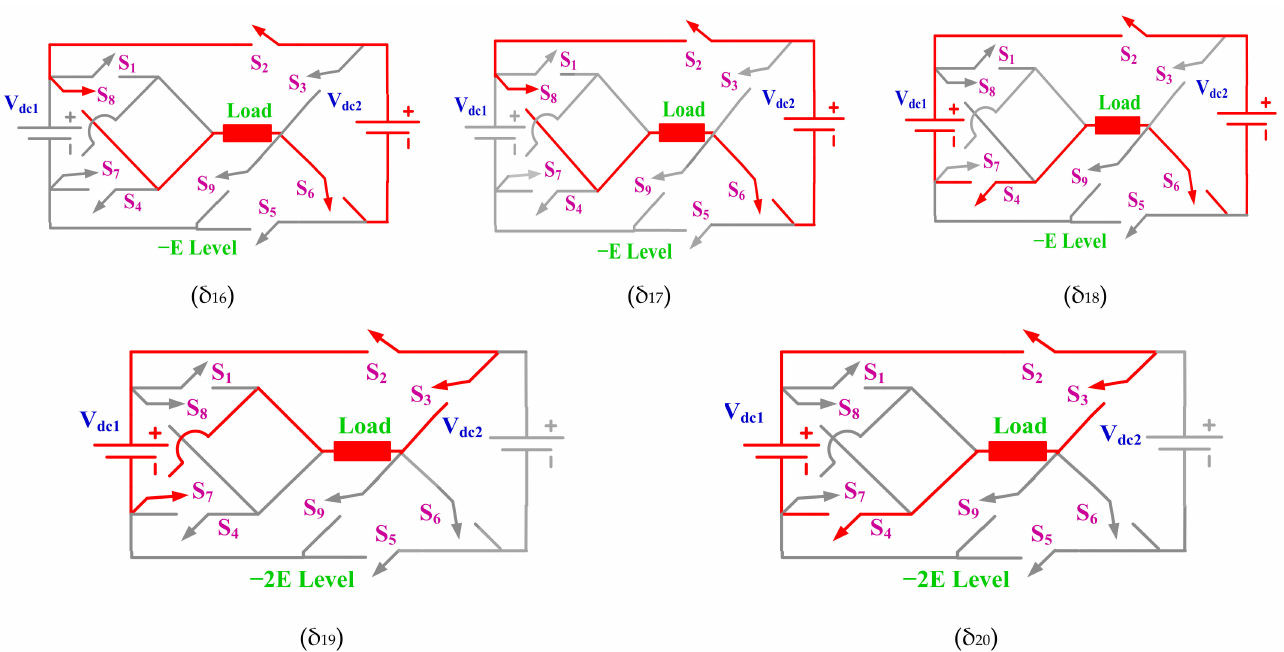
Figure 3. All twenty switching states of proposed five-level fault-tolerant topology. Table 3. Different modes for any single switch OC fault in proposed five-level fault-tolerant topology. Failed Switch Available Modes Operation